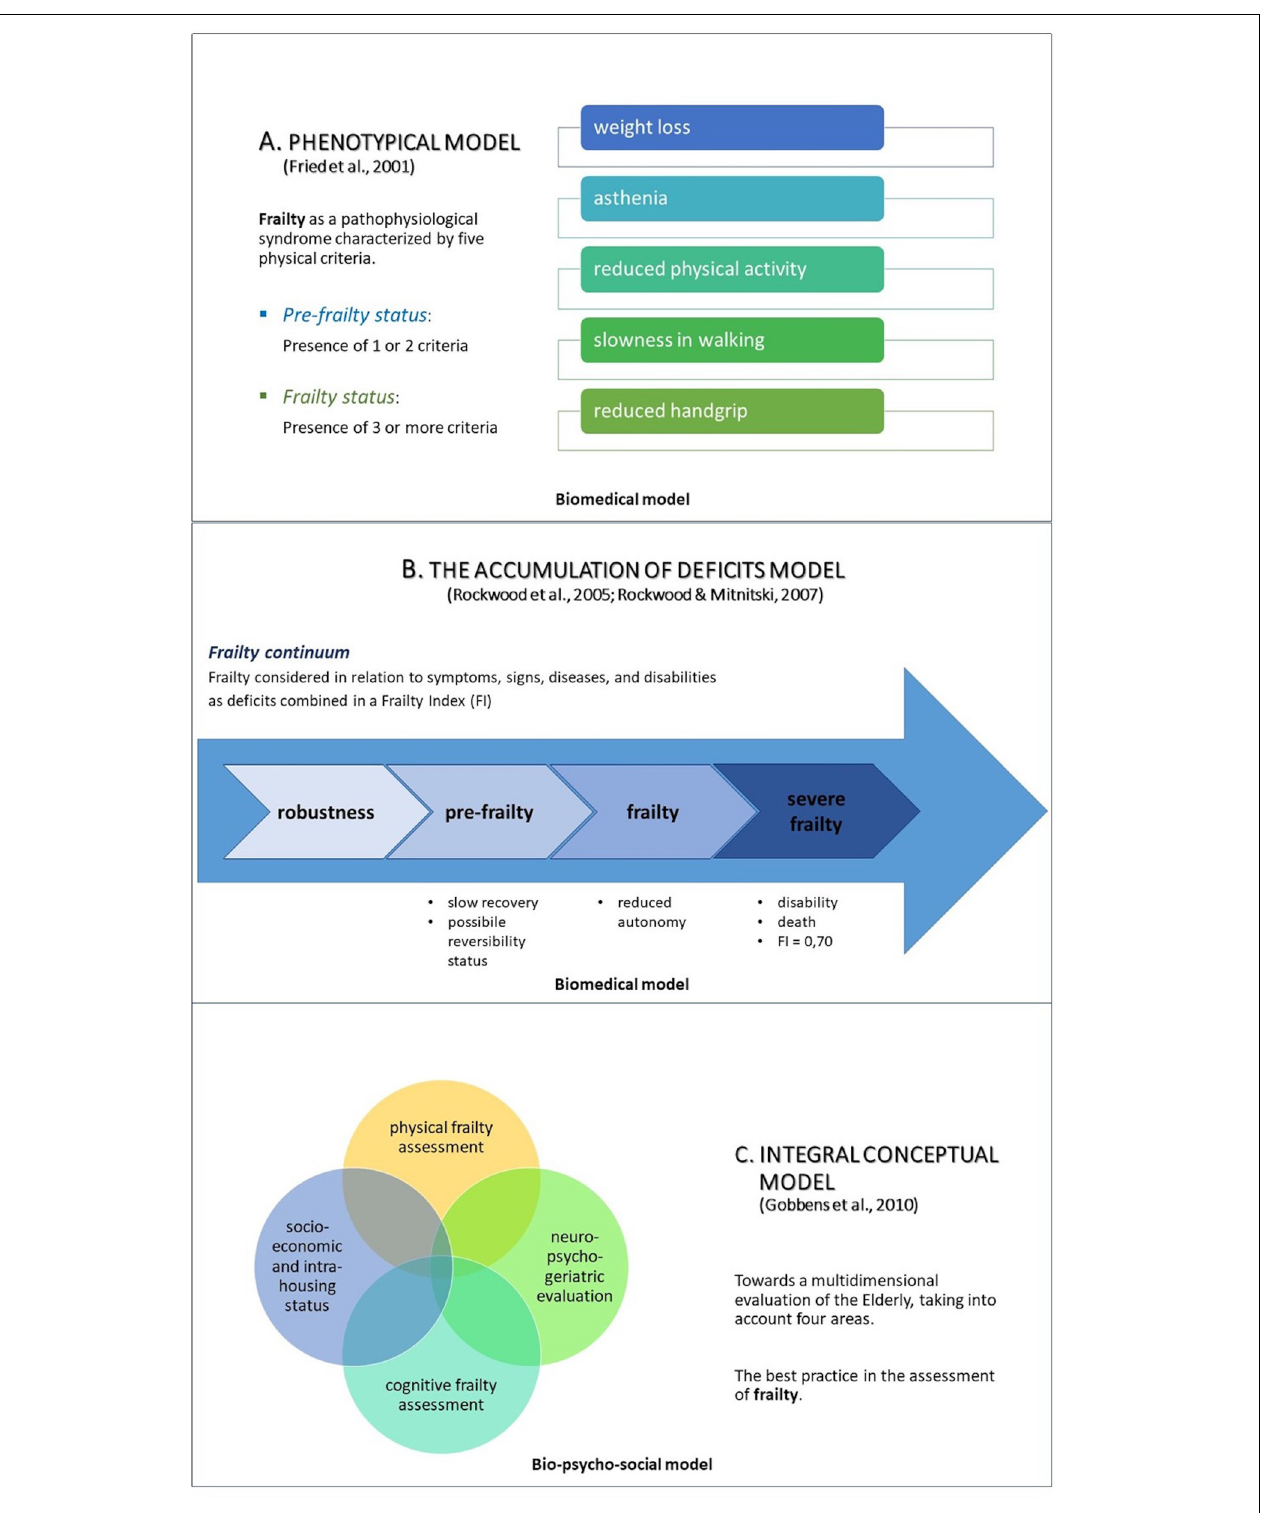
FIGURE 1 | The three main approaches to study frailty: the phenotypical model (Fried et al., 2001; A ), the accumulation of deficits model (Rockwood et al., 2005; Rockwood and Mitnitski, 2007b; B ), and the integral conceptual model, based on a bio-psycho-social approach (Gobbens et al., 2010; C ).